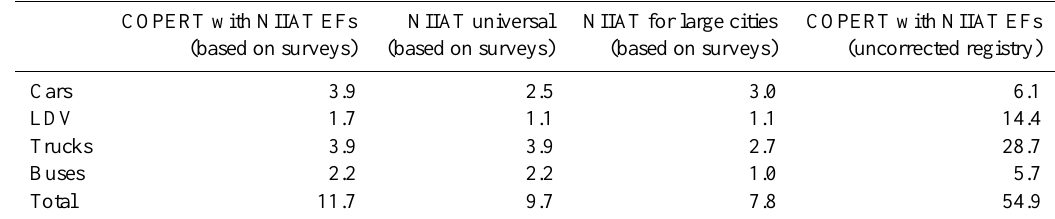
Table 4. BC emissions in Murmansk City from on-road transport, different methodologies, tyr − 1 . COPERT with NIIAT